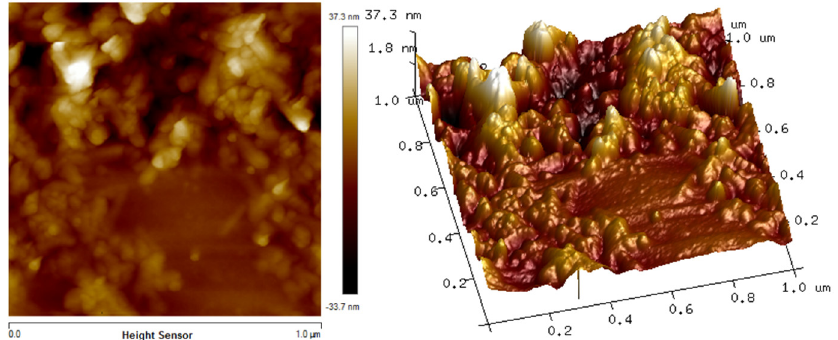
/ Fe 2 O 3 thin film.